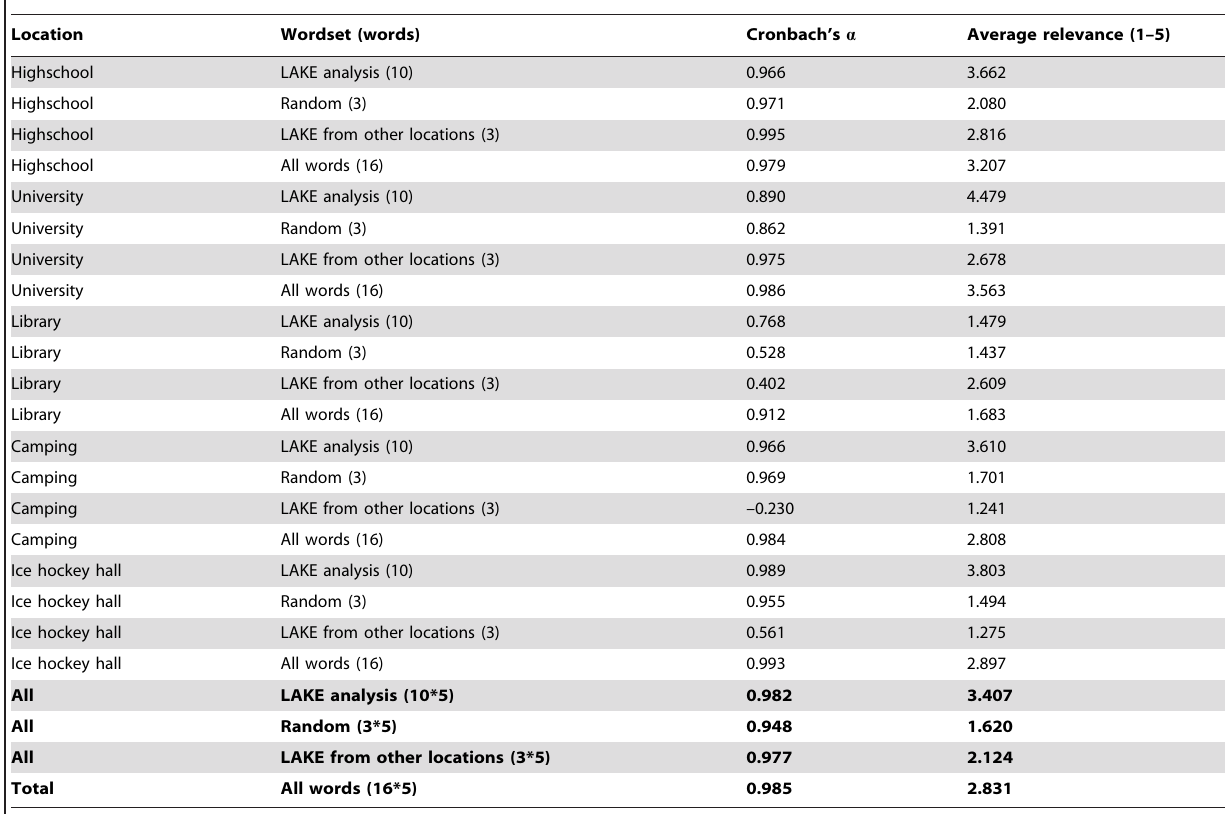
Table 5. Results of the questionnaire on LAKE